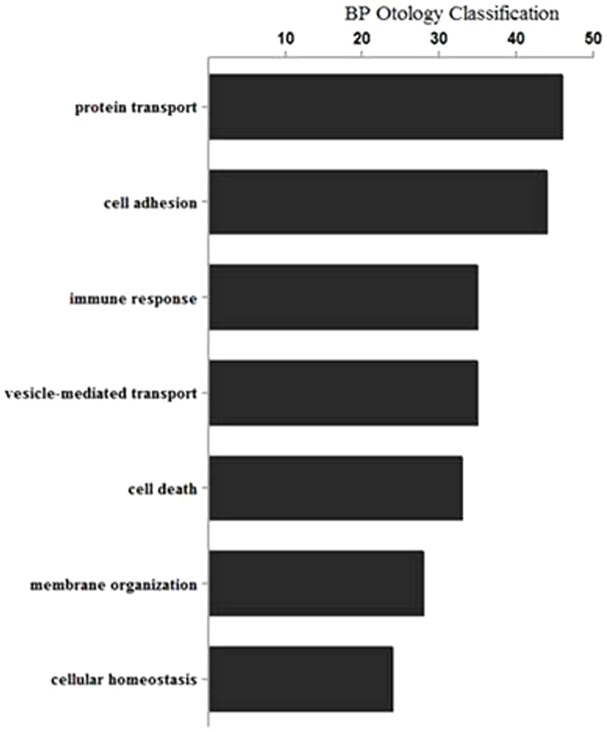
Gene ontology analysis of differentially expressed proteins in the cochleae of Ildr1+/− and Ildr1−/− P21 mice using the online DAVID software.The x-axis shows the number of proteins in each category.